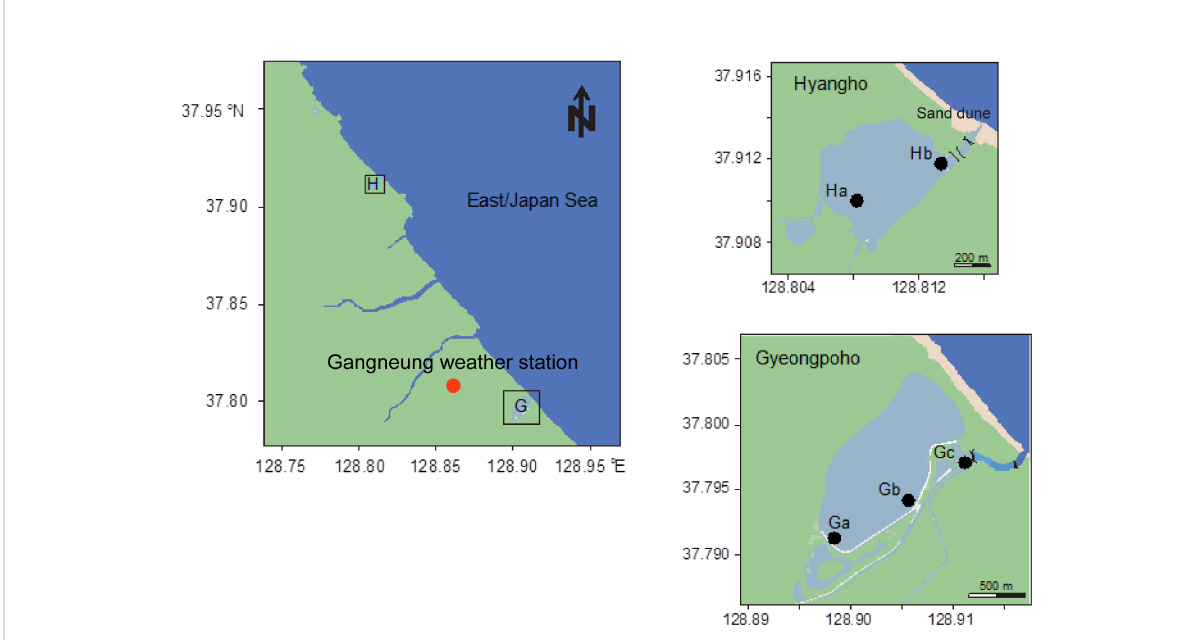
FIGURE 1 Map of the two coastal lagoons located along the eastern coast of the Korean